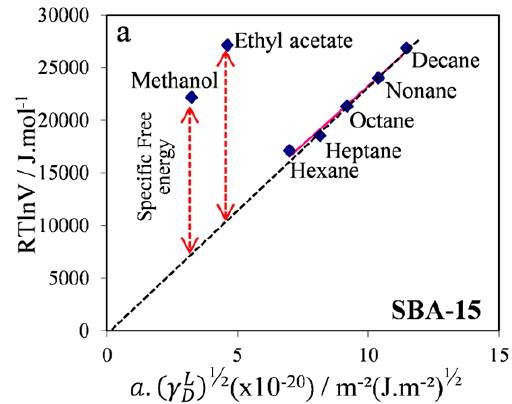
Figure 4. Application of inverse gas chromatography (IGC) to determining γ S Adapted from Reference [59]; copyright (2014) with permission from